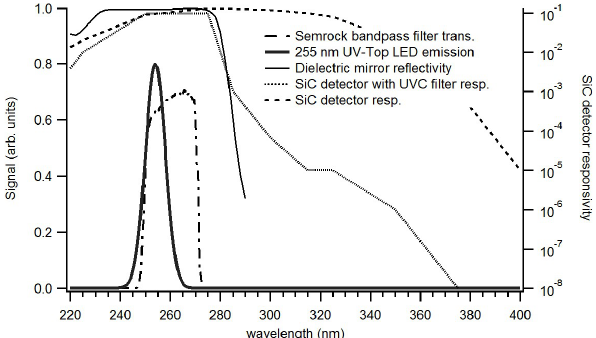
Figure 2. Wavelength dependence of components in the system. 2 Fig. 2. Wavelength dependence of components in the 3